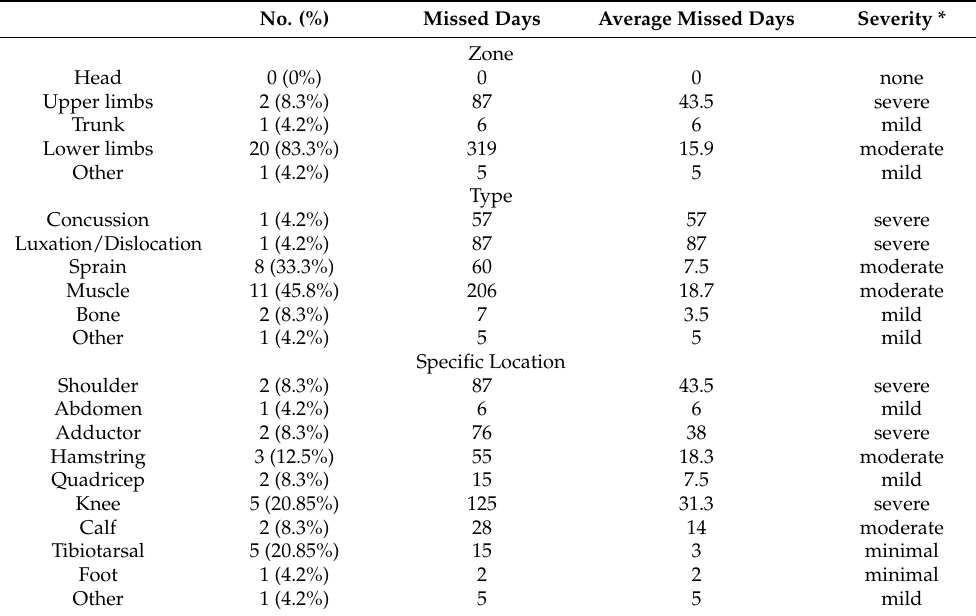
Table 3. Injury characterization per zone, type and specific location during 2021/2022 season. No.